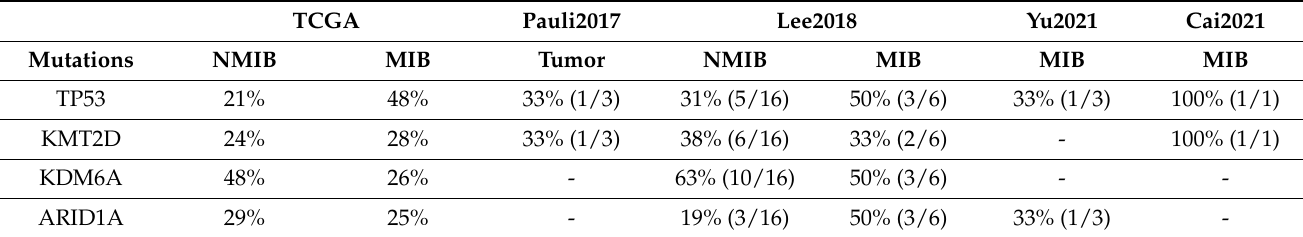
Table 3. Mutation profile of the organoid lines in comparison with reference cohorts for